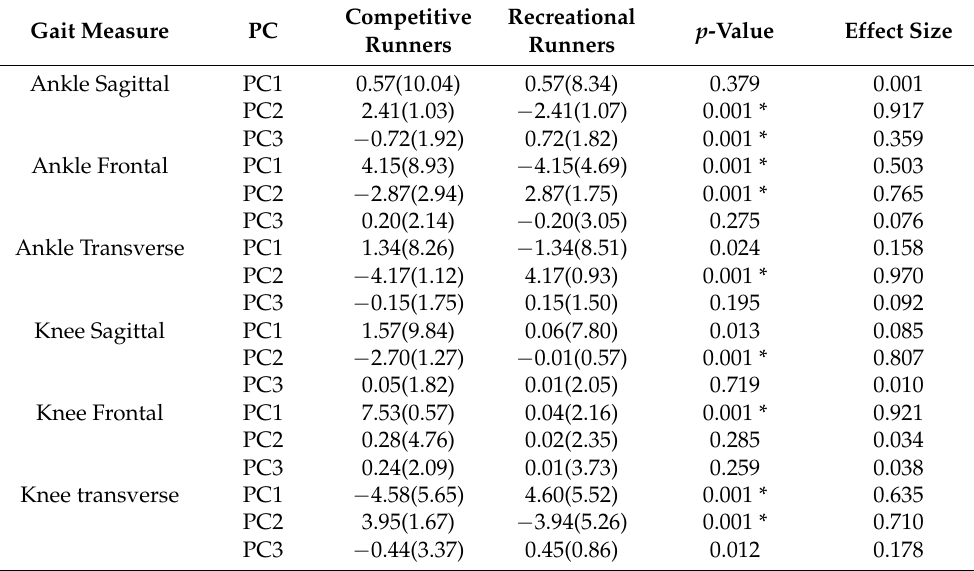
Table 2. The first three principal components (PCs) are retained according to the 90% trace criterion for the competitive runners and recreational runners; p -value 0.005 represents